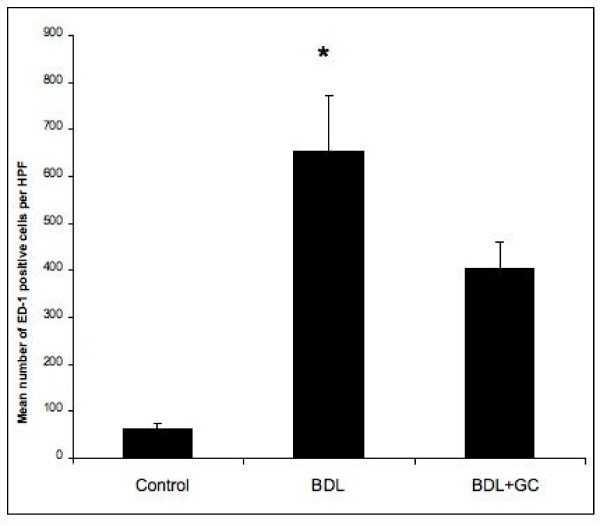
Numerical counts of PIMs: Septal ED-1 positive cells showed increase in PIMs in BDL rats compared to the normal rats or at 48 hours after GC treatment of BDL rats (*: P < 0.05).